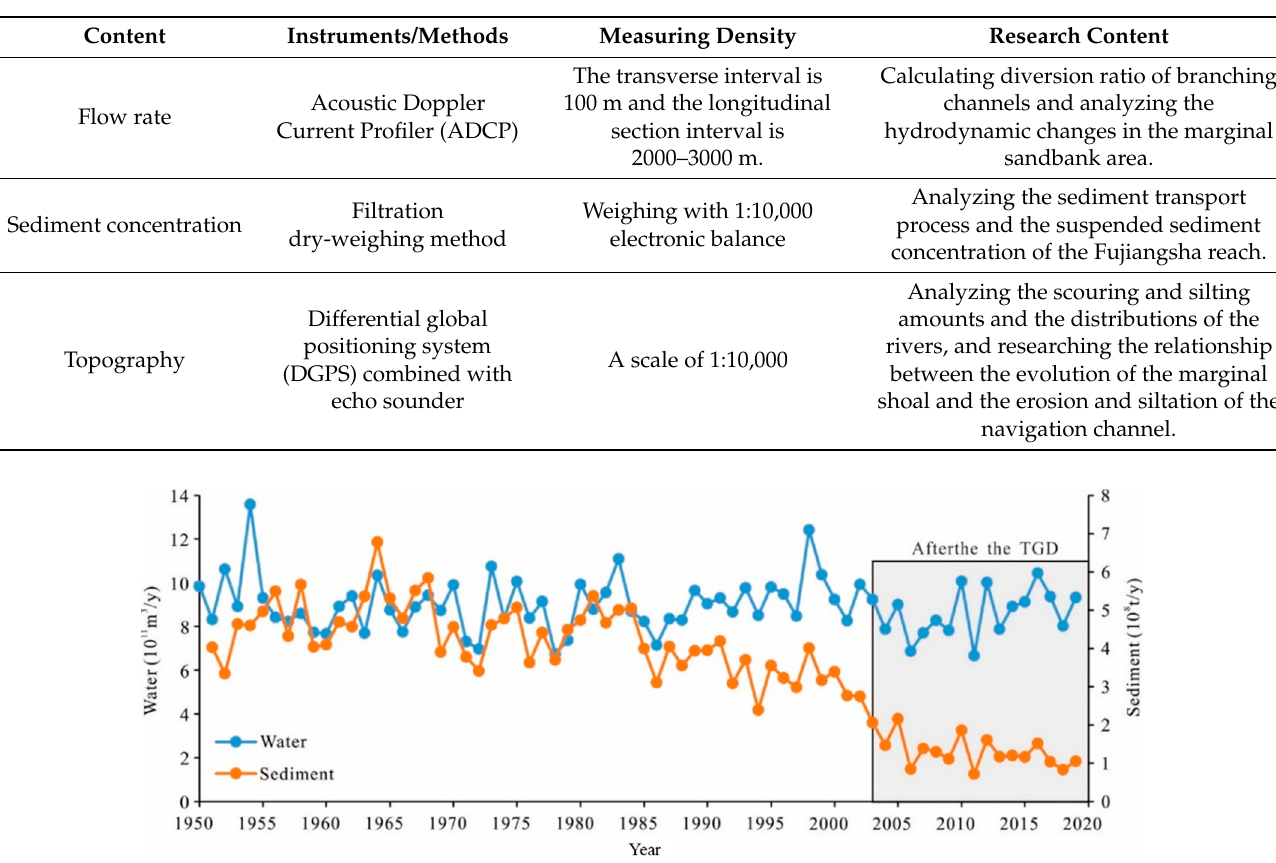
Table 1. Materials used in the study and parameter comparison.